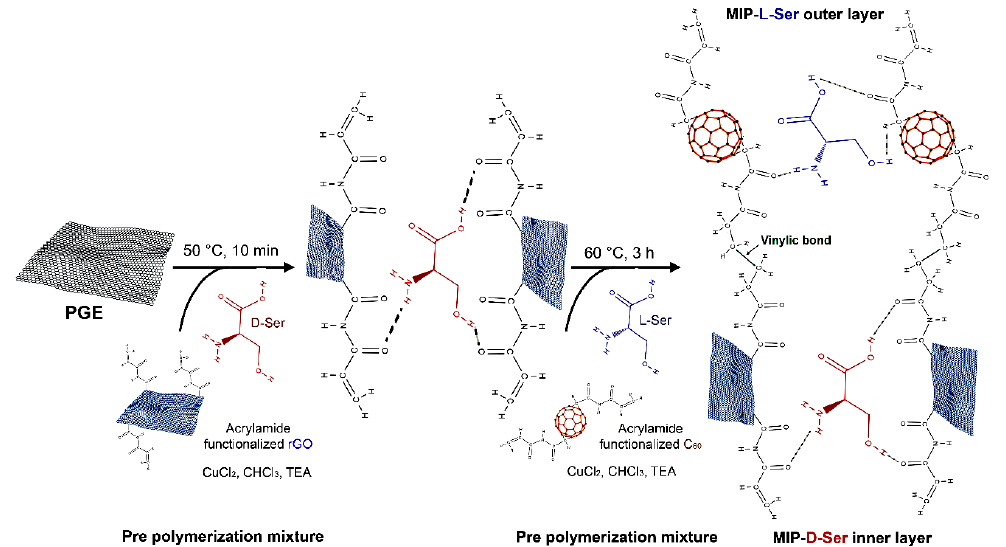
Figure 5. Scheme of the electrochemical biosensor to assay both D- and L-Ser [78]. The system was obtained by generating acrylamide functionalized reduced graphene oxide-fullerene, assembling dual molecularly imprinted polymers (MIPs) layer-by-layer: a pencil graphite electrode (PGE) was initially spin coated with D-Ser imprinted acrylamide functionalized reduced graphene oxide (rGO) and, after a thermal treatment, the electrode was again modified with L-Ser imprinted acrylamide functionalized fullerene molecules (C 60 ). Modified from [78].